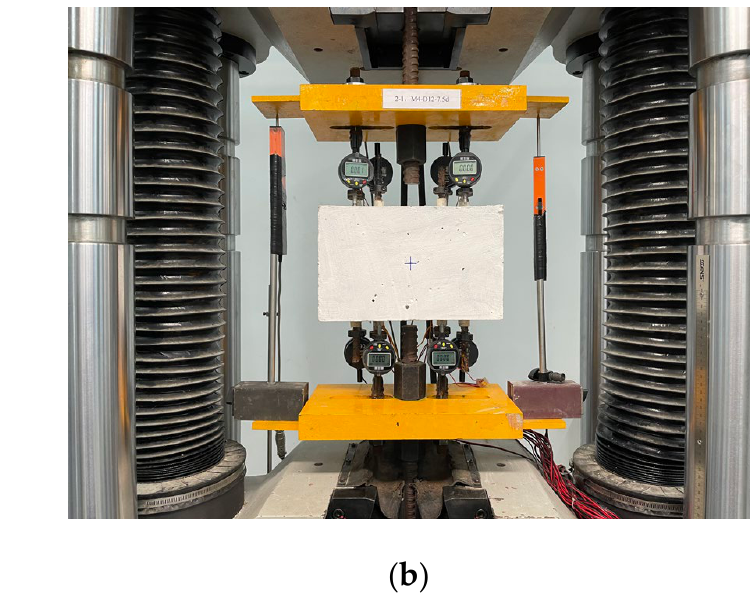
Figure 4. Load frame ( a ) Loading sketch; ( b ) Load frame with a specimen settled down. During the test, displacement transducers (LVDTs) were employed to measure the axial deformation of CHBC (Figure 4). Additionally, micrometer calipers were used to observe the slip between the headed rebar and concrete (Figure 5a). In addition, strain gauges were placed on the headed bars and stirrups, respectively, (Figure 5b) to detect the strain development.